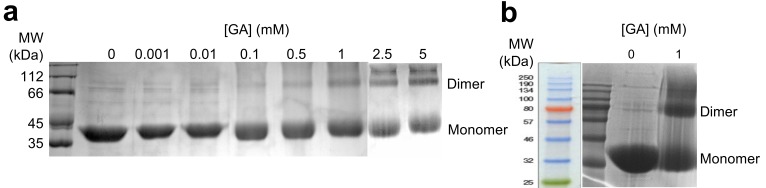
DRD4 cross-linked with glutaraldehyde.(a) SDS-PAGE of DRD4 sample cross-linked with a concentration gradient of glutaraldehyde (GA). Bands of protein dimers are clearly visible at 0.5 mM GA. (b) Detailed marker shows that the molecular weight of cross-linked band is approx. 80 kDa, which is twice the size of a DRD4 monomer.